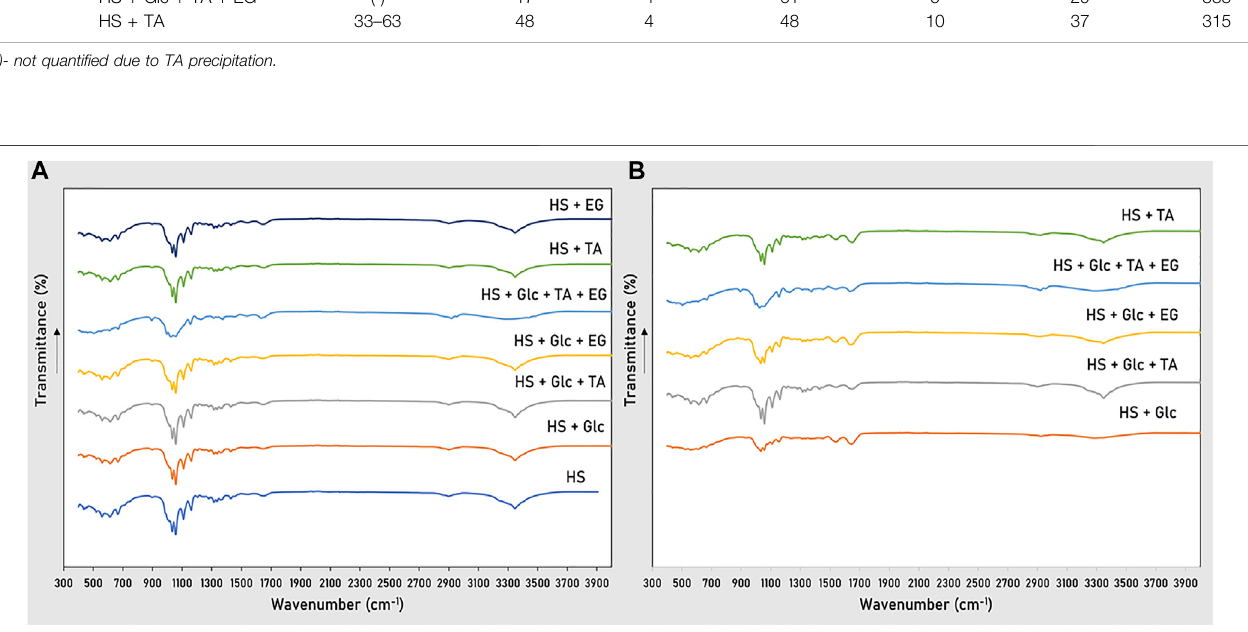
FIGURE 4 | FTIR spectra of the chemical groups present in BC grown in glucose, TA, and EG by K. xylinus DSM 2004 (A) and DSM 46604 (B) .